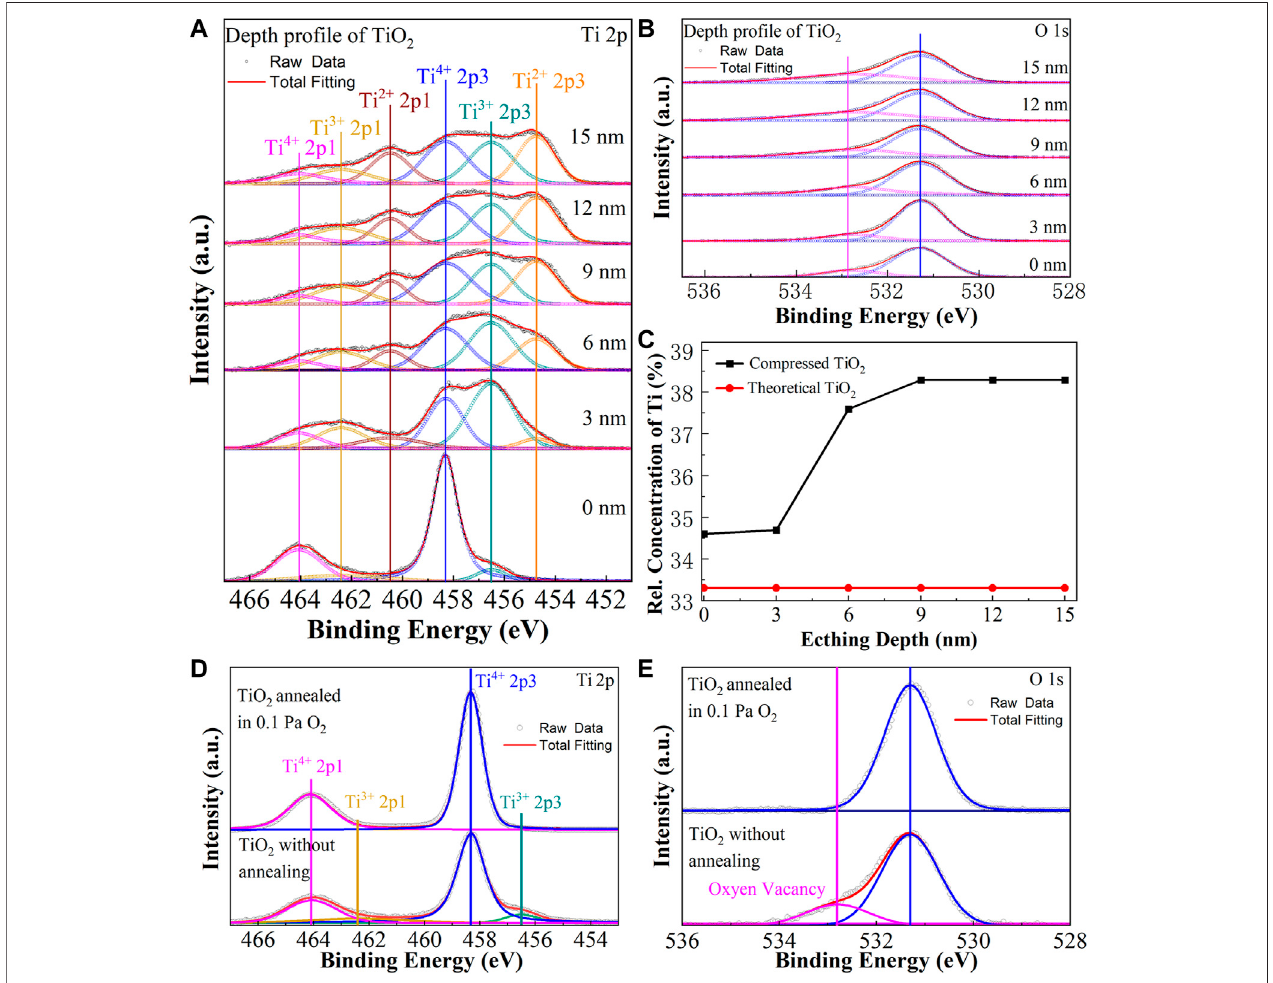
FIGURE 3 | Ex-situ XPS spectra of (A) Ti 2p and (B) O 1s at different depths. (C) Relative concentration of Ti atoms as a function of etching depth. (D) Ex-situ XPS spectra of Ti 2p with and without in-situ annealing in 0.1-Pa O 2 . (E) Ex-situ XPS spectra of O 1s with and without in-situ annealing in 0.1-Pa O 2 .